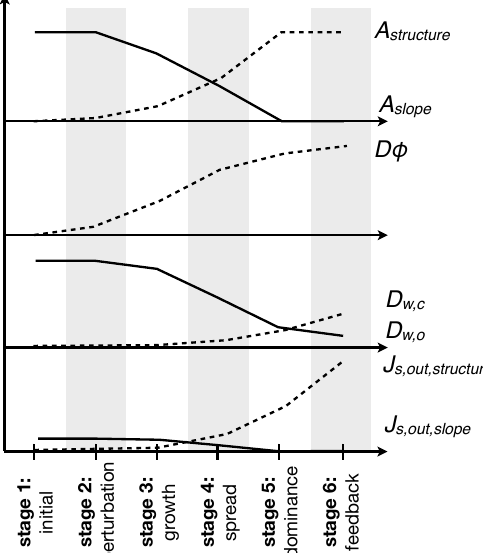
Fig. 8. Qualitative sketch of the change in variables associated with river network structure formation in relation to the different stages shown in Fig. 7. Shown are from top to bottom: the areal extent of the structure, A structure , in relation to the remaining area of the slope, A slope ; the disequilibrium, Dφ , of the local geopo- tential gradient, ∇ φ i , in relation to the mean gradient of the slope, ∇ φ ; the frictional dissipation by overland flow, D w,0 , and by chan- nel flow, D w,c ; and the resulting sediment export by the structure, J s,out,structure , and by the remaining slope, J s,out,slope .